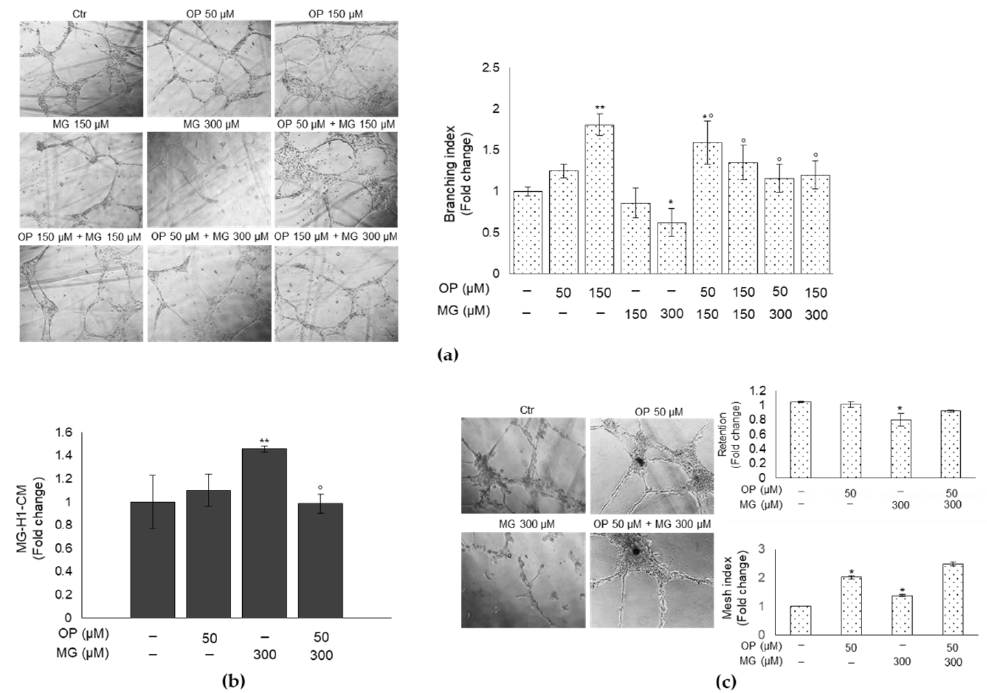
Figure 5. OP prevents DPSCs exposed to MG from affecting tube formation of HUVECs. ( a ) Representative images of HUVECs exposed to conditioned medium (CM) from DPSCs untreated and treated with 150 and 300 µ M MG, OP 50 and 150 µ M alone or combined. MG determined a reduction of the number of tubules formed (significant at 300 µ M), as represented by analysis of the branching index (a measure of the number of junctions formed per vessel area). This effect was prevented by OP pretreatment both at 50 and 150 µ M. This finding was positively correlated with ( b ) MG-H1 levels in CM from DPSCs treated with 300 µ M MG that contained markedly higher levels of MG-H1 compared with control cells, while these levels were significantly lower in the CM of DPSCs pretreated with 50 µ M OP. ( c ) Representative images of co-cultures of DPSCs and HUVECs exposed to 300 µ M MG, OP 50 alone or combined. MG determined a reduction of tubules stabilization as represented by analysis of % of retention and mesh index. This effect was reverted by OP. Histograms indicate the means ± SD of three different cultures, each of which was tested in triplicate. * p < 0.05 and ** p < 0.01, significantly different from control untreated cells. ◦ p < 0.05, compared to MG-treated